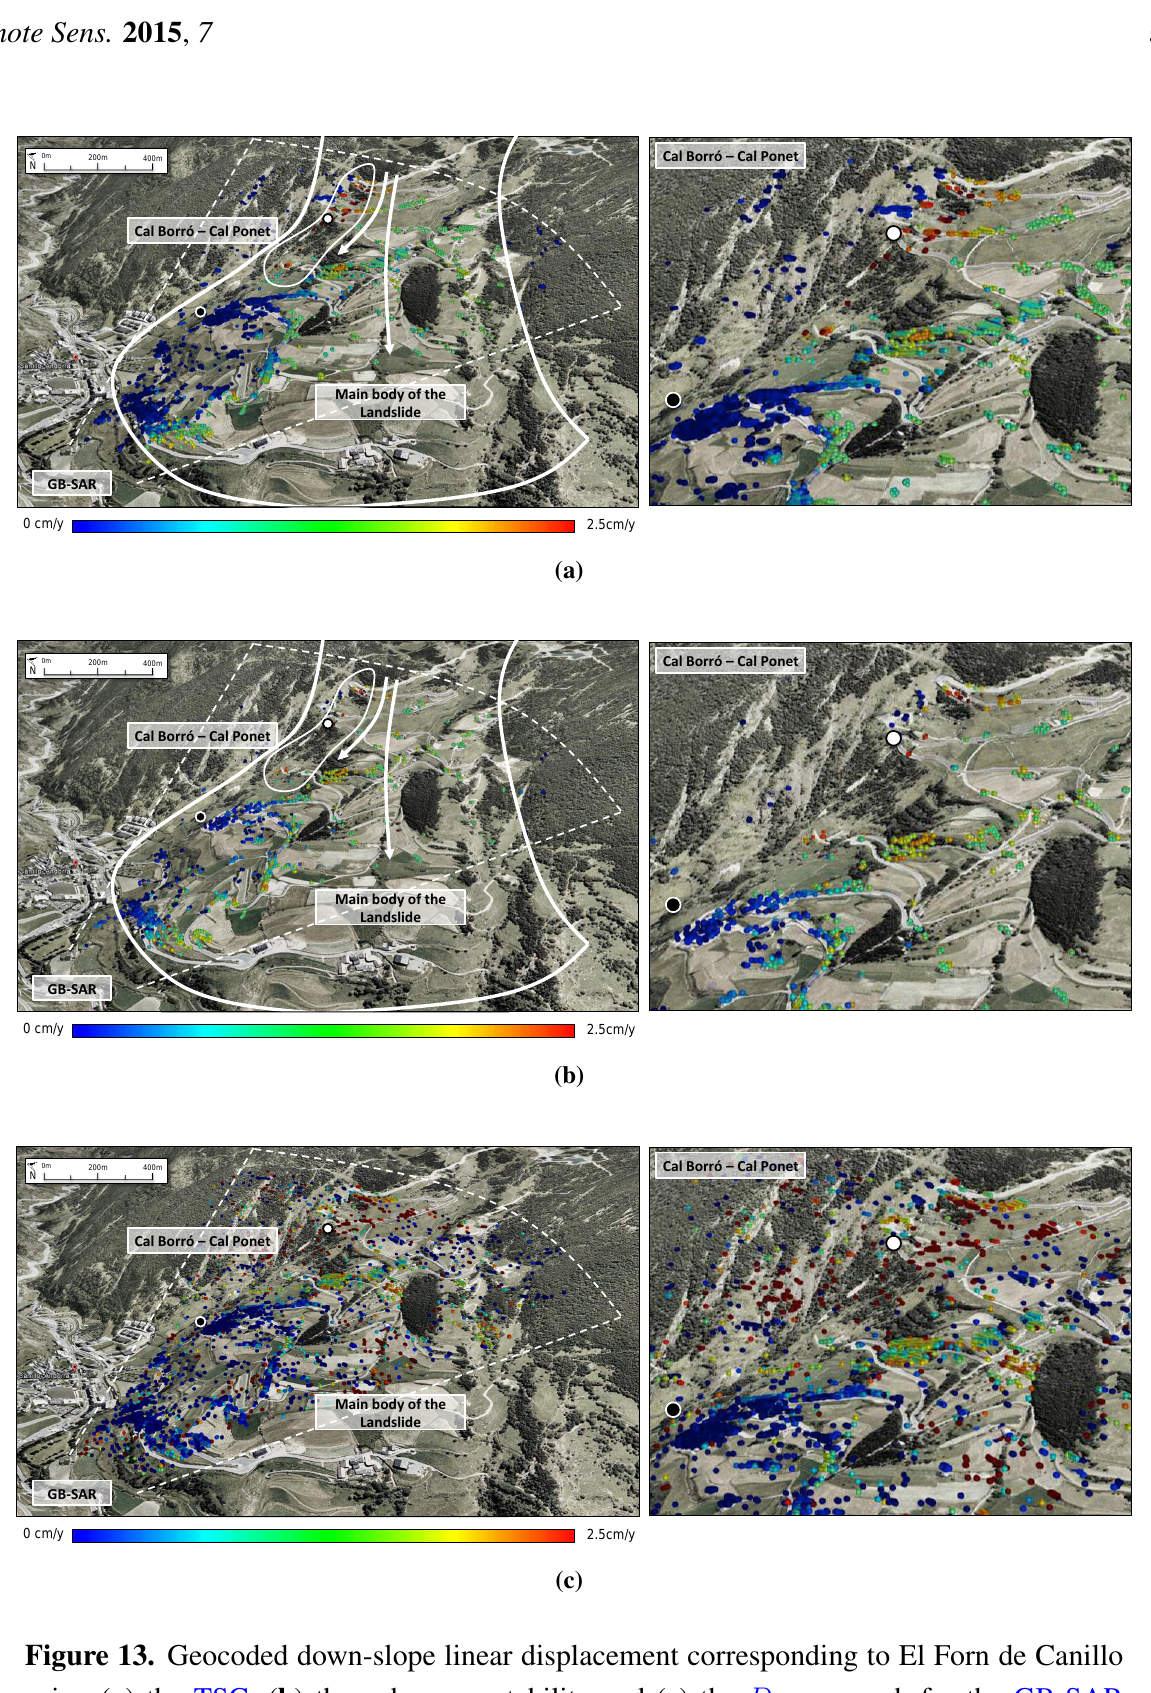
approach for the GB-SAR A